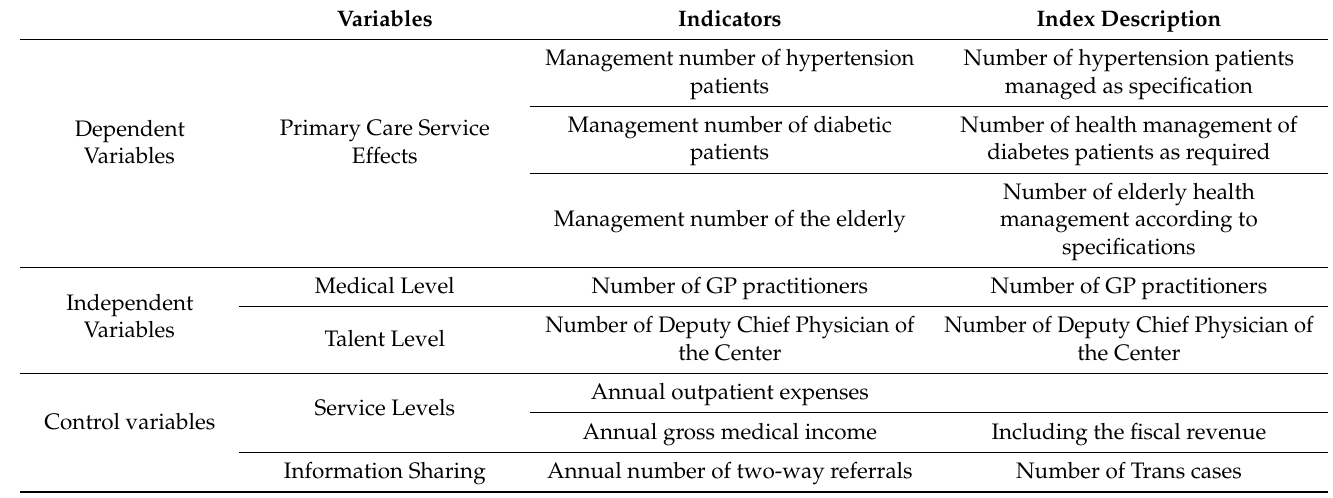
Table 4. Variables